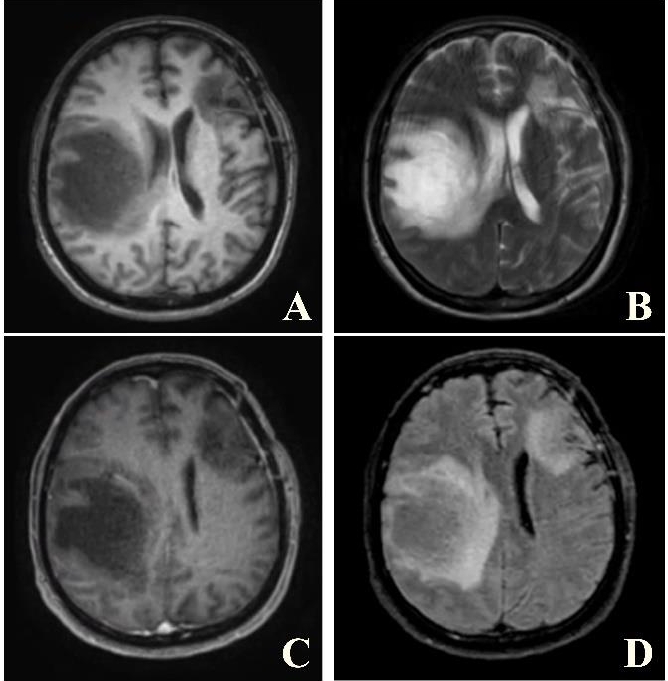
Figure 2. Axial T1W ( A ), T2W ( B ), post-contrast T1W ( C ) and post-contrast FLAIR ( D ) images of the same patient reveal tumor-like lesion with surrounding vasogenic edema at left frontal and right parietal lobes. The patient was suspected to have high-grade glioma and underwent biopsy. Pathological result was consisted with demyelination, yielding a final diagnosis of tumefactive MS. The patient was given treatment with high-dose steroids.